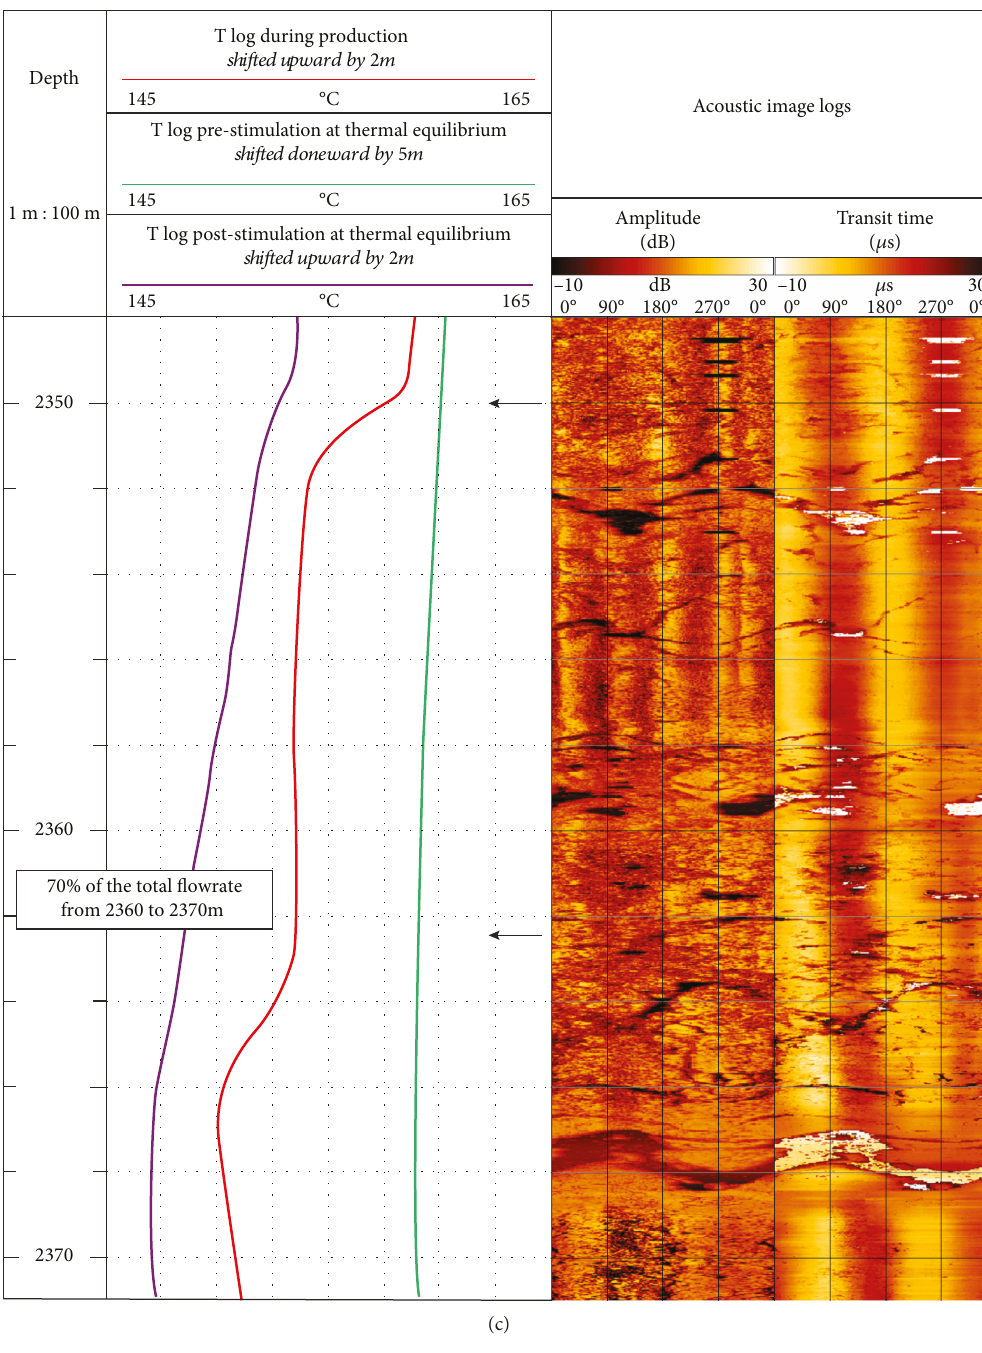
Figure 8: T logs obtained from well GRT-1 during production (Jan 2013, airlift production), at thermal equilibrium prestimulation (Apr 2013, four months after hydraulic tests) and poststimulation (Dec 2013, fi ve months after hydraulic stimulation). Dotted lines indicate the gradient of the T logs during production (red) and poststimulation (purple). T anomalies are associated with open fractures observed in acoustic image logs at (a) 2236m MD, (b) 2345 m MD, and (c) 2368 m MD. Arrows indicate in fl ows of geothermal water through fractures. Depth is expressed in MD. T logs and fl ow logs were shifted manually to match anomalies with fracture